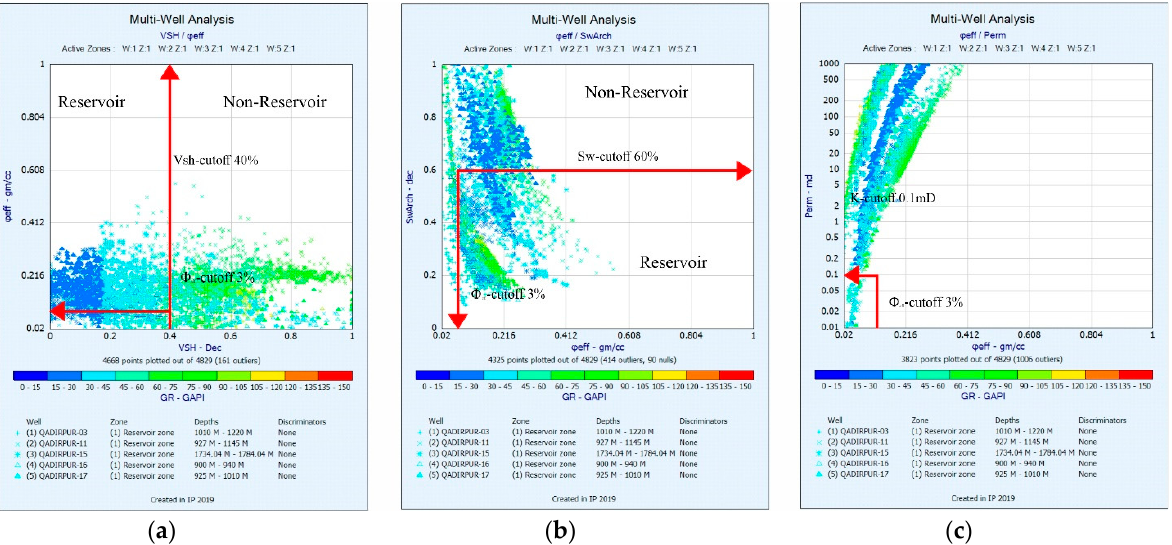
Figure 11. QGF well 03. ( a ) Shale concentration versus effective porosity; ( b ) effective porosity versus water saturation; and ( c ) effective porosity versus permeability cross-plot, with gamma-ray scales for cutoff determination.